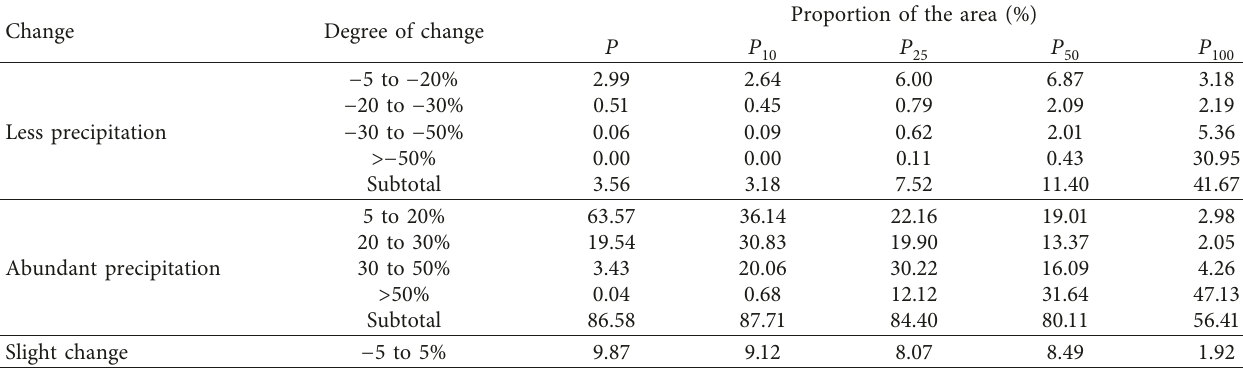
Table 4: The proportion of the area with different degrees of change in precipitation from 2007 to 2016 compared with 1966–2016 in the HLR.